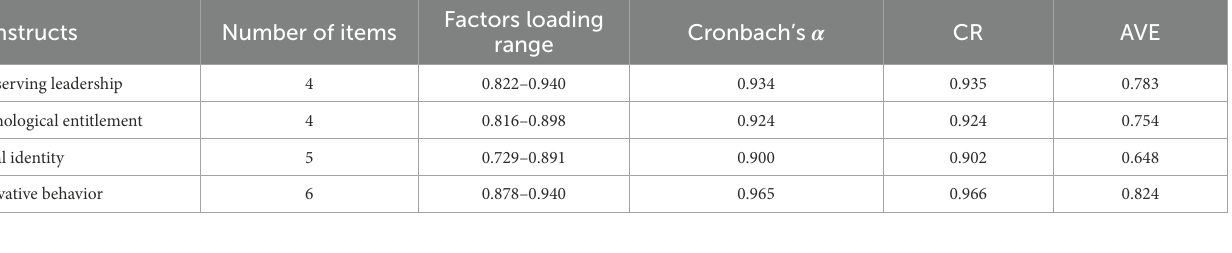
TABLE 2 Results of confirmatory factor analysis.